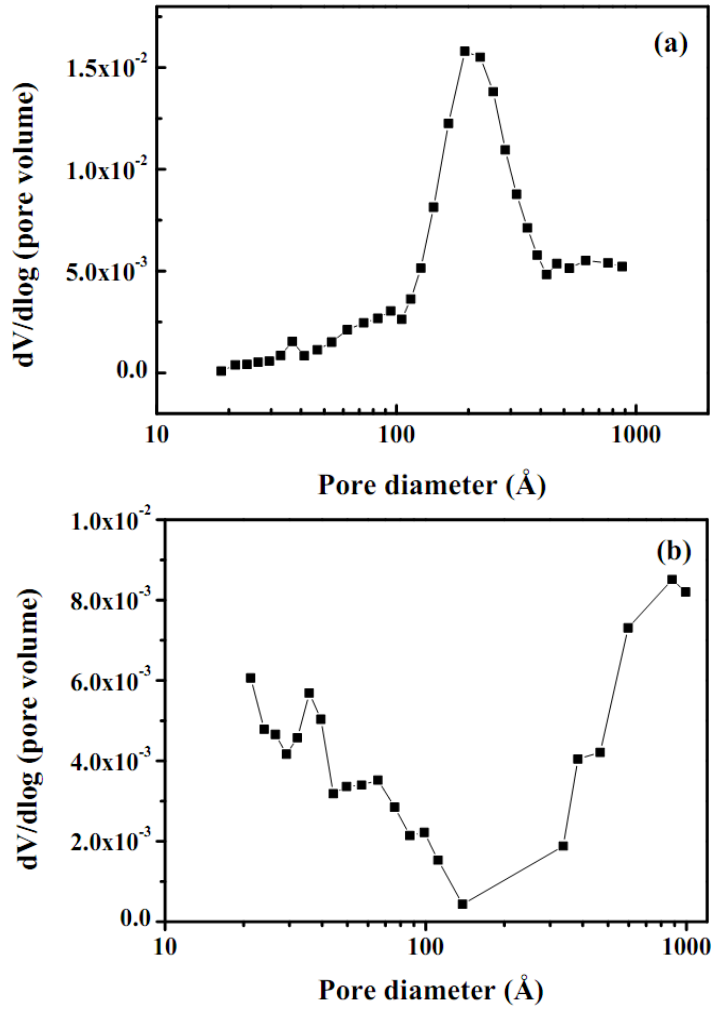
Figure 6. Pore size distribution for (a) as-synthesized catalyst and (b) as synthesized catalytic mixtures with ZrO 2